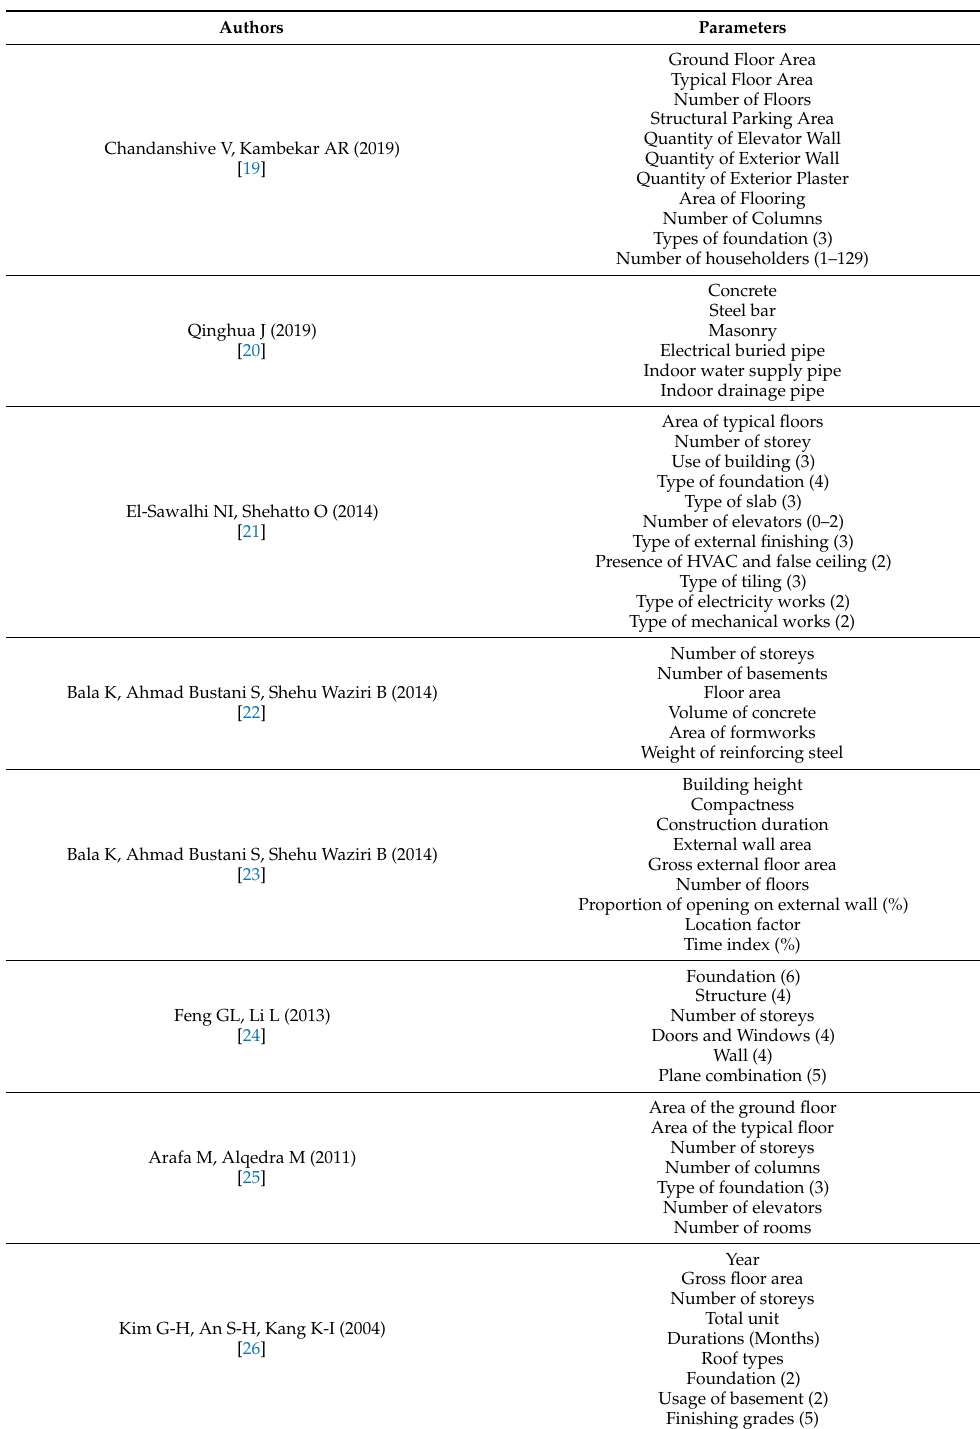
Table 2. Influence factors of building cost estimation in research